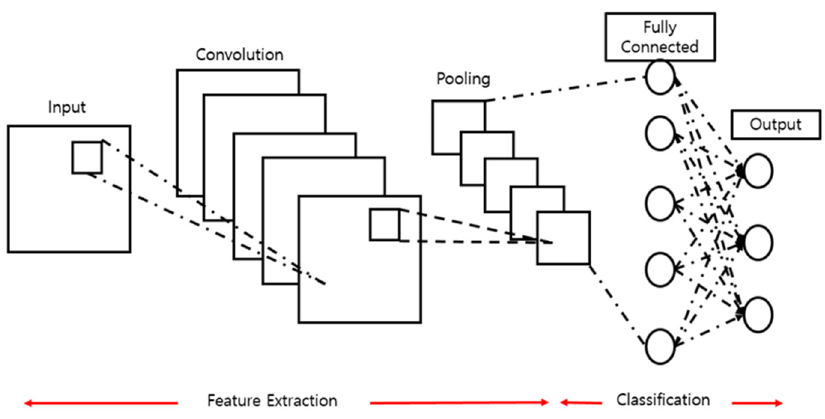
Figure 25. Architecture of CNN.